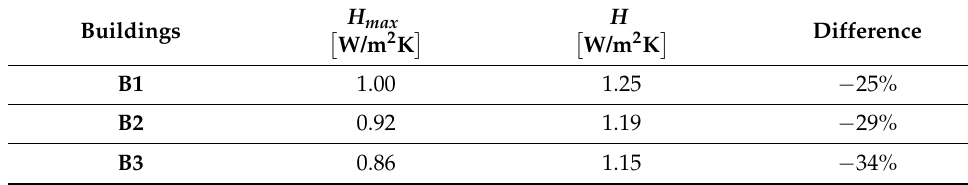
Table 3. Overall heat coefficients 𝐻 . Buildings